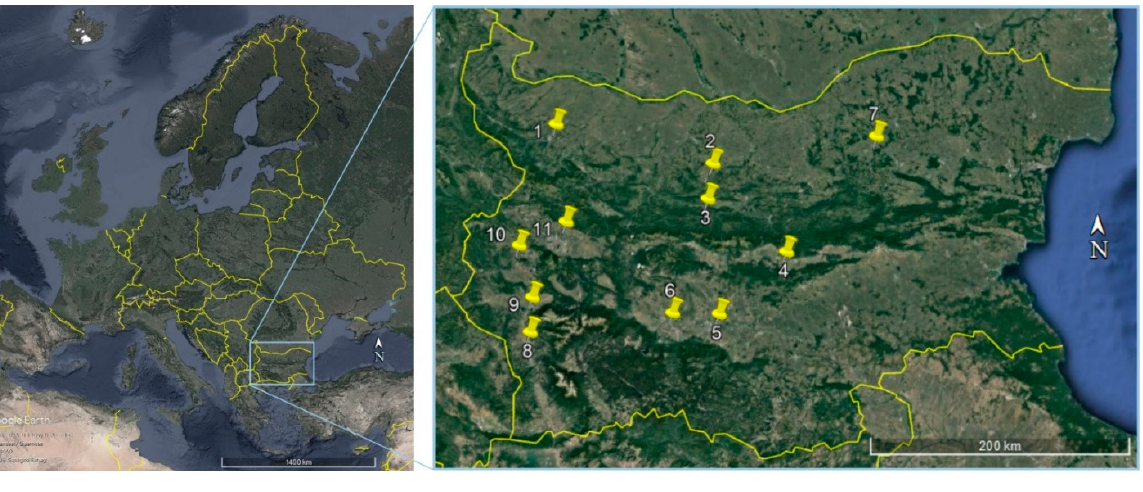
Figure 1. Sampling locations of the WWTPs.